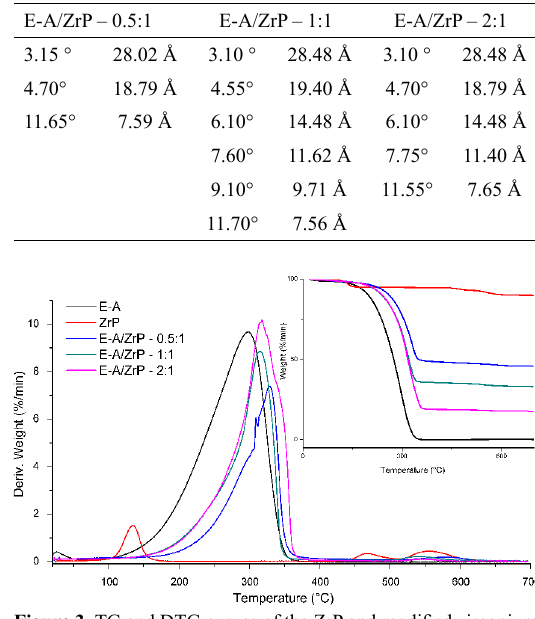
Figure 3. TG and DTG curves of the ZrP and modified zirconium